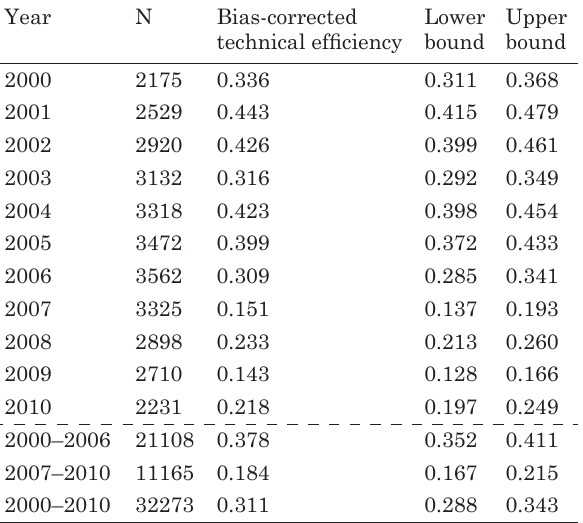
Table 3. Evolution of bias-corrected technical